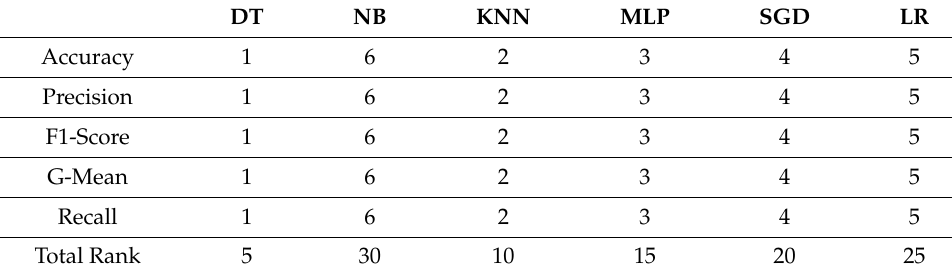
Table 6. Ranks for the different measures (Udacity